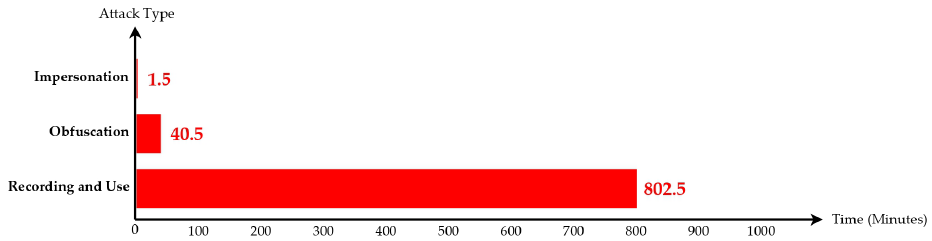
Figure 12. No defense attacks (since AES encryption only has the effect of confusion, it takes only 802.5 min to complete the signal replication and only 40.5 min to start the obfuscation attack; thus, the time required is